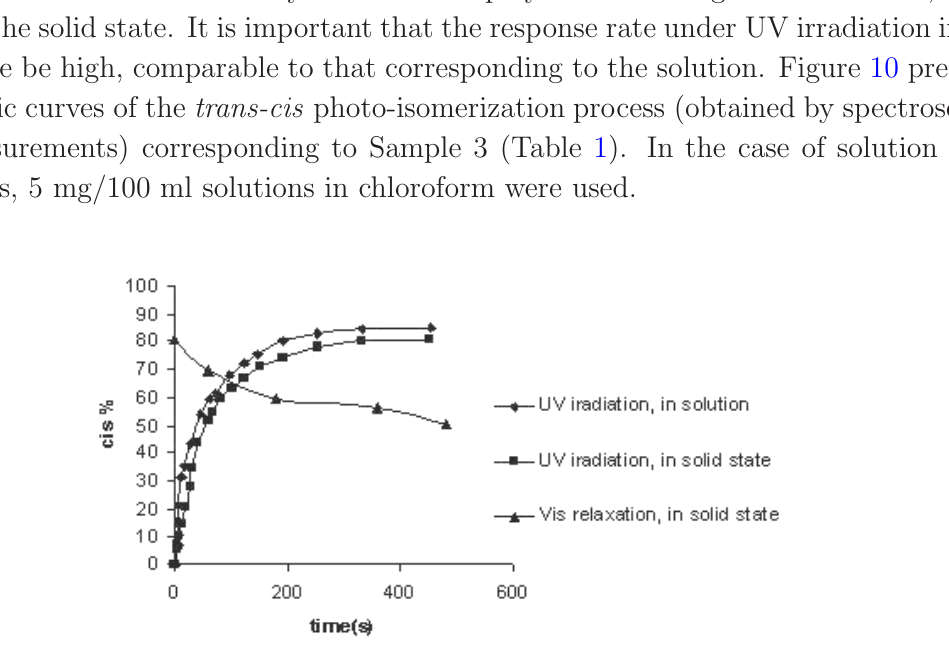
Fig. 9 The kinetic curves corresponding to the trans-cis isomerization in solution and in solid state and cis-trans relaxation processes in solid state of Sample